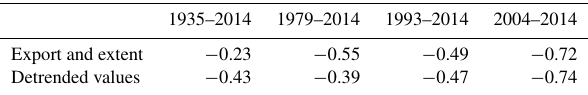
Table 1. Correlations over time between Fram Strait spring export and mid-September sea ice extent ( r FS ice export-Sept SIE